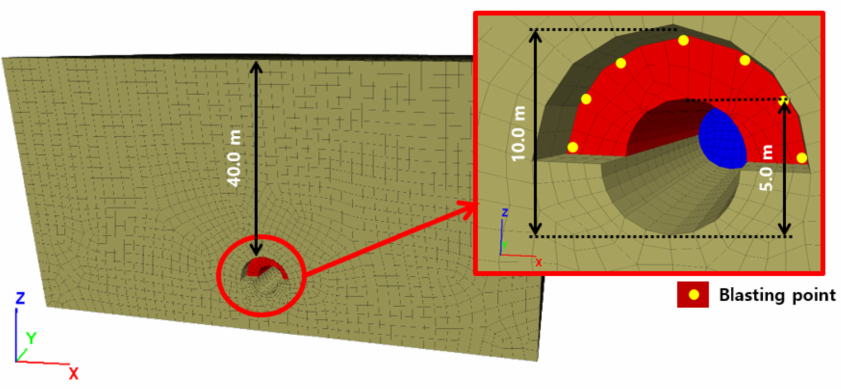
Figure 1. Numerical analysis modeling of the ground and TBM.